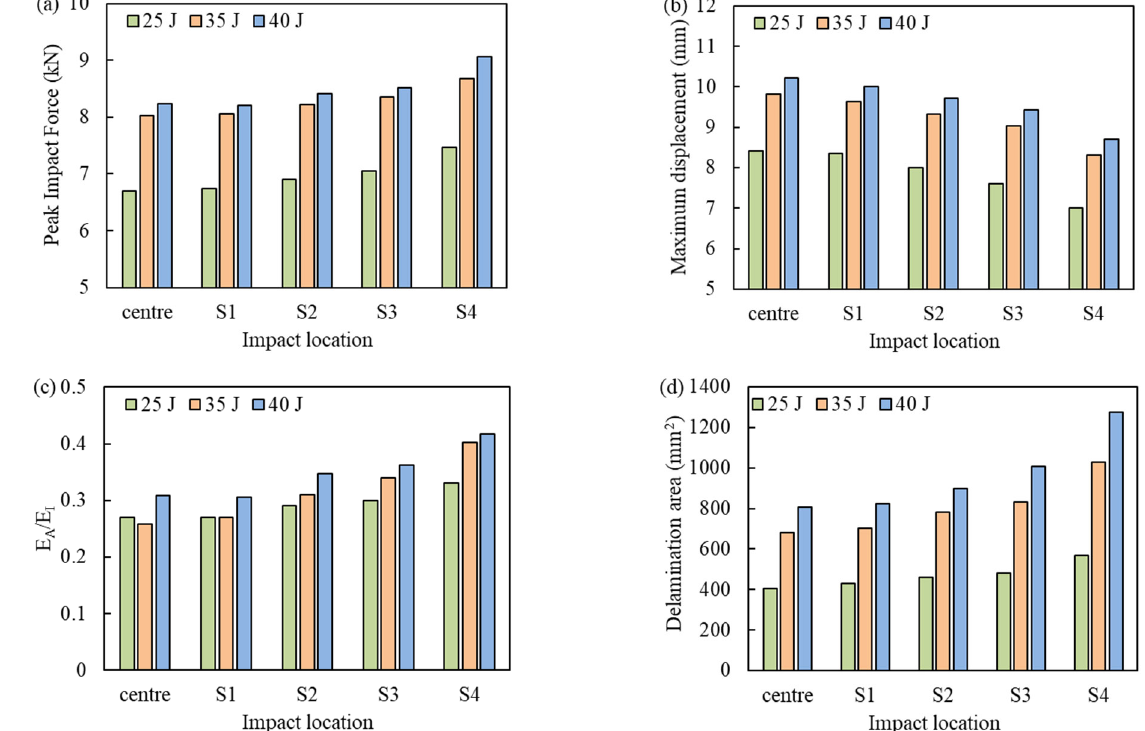
Figure 8. Comparison of the center and off-center low-velocity impact responses. ( a ) Peak impact force, ( b ) Maximum displacement, ( c ) Ratio of absorbed energy to impact energy, and ( d ) Projected delamination area.